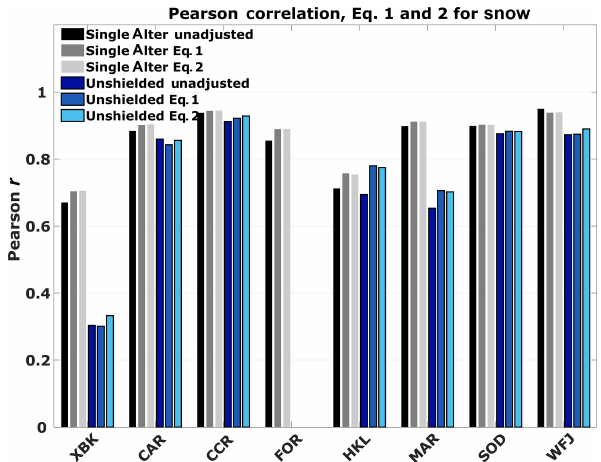
Figure 7. Pearson r for single Alter and unshielded gauges for unadjusted measurements and for adjustments using Eqs. (1) and (2) at each of the eight SPICE sites, combining 2015/2016 and 2016/2017 winter